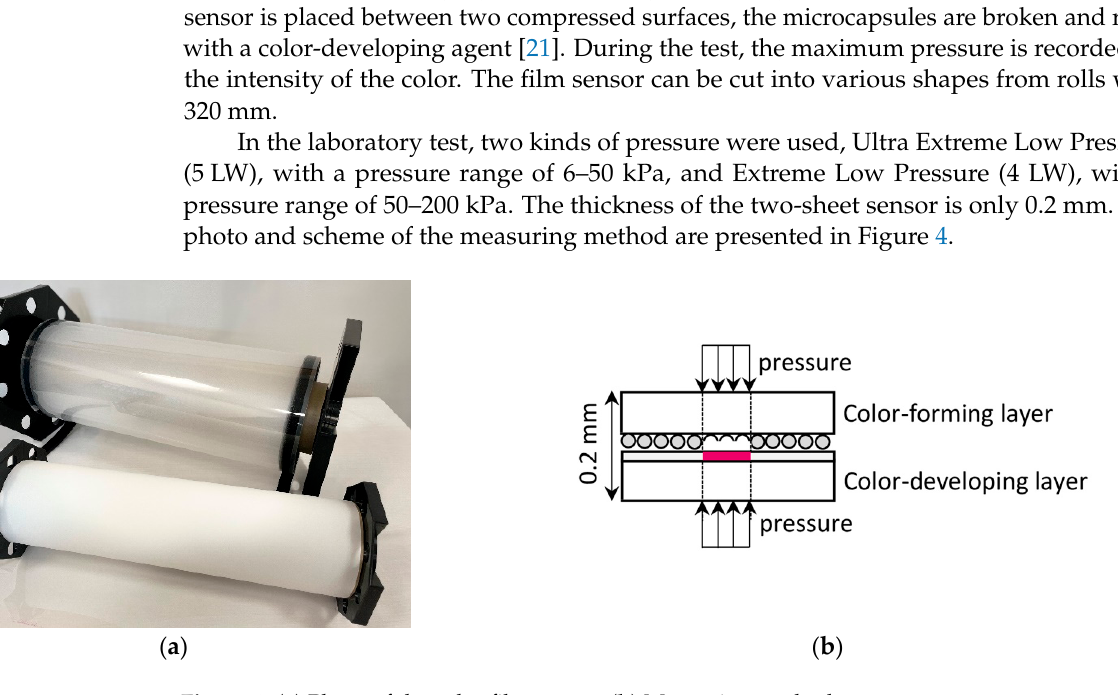
Figure 4. ( a ) Photo of the color film sensor. ( b ) Measuring method .